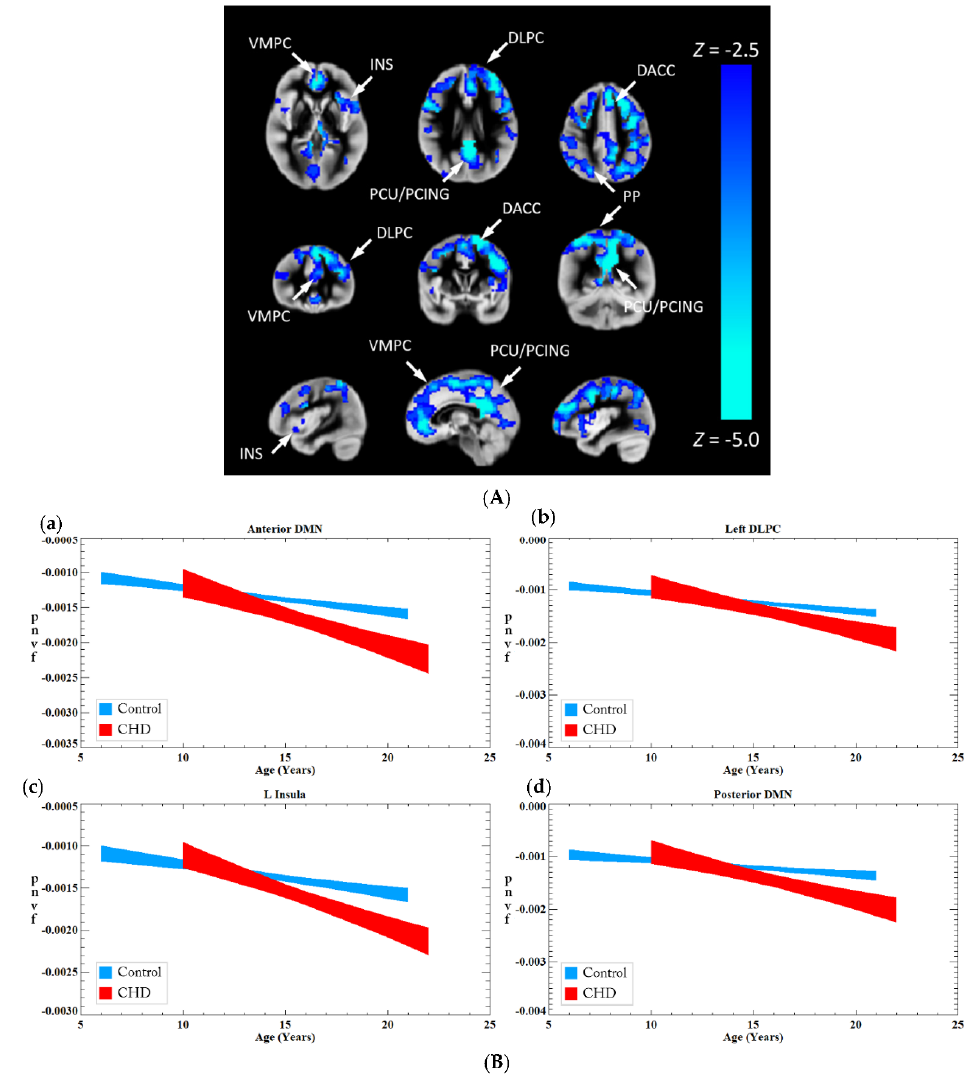
Figure 3. ( A ) A CHD-X-age interaction on Pnvf is present in children and younger adults. For illus- trative purposes, the trajectories of CHD patients and normal referents were computed separately for the ROIs shown to exhibit a significant interaction from the voxel-wise analysis depicted in ( B ). These plots show the fitted trajectories +/ − standard error of the fitted value (confidence interval = 67%). The plots show that, while at the earliest age (5 years) CHD patients have either the same or slightly higher Pnvf, the trajectory is such that they have substantially lower Pnvf by young adulthood. Regions with a negative CHD-X-age interaction on Pnvf (controlling for gender) are mainly concentrated in default mode network (DMN), central executive network (CEN), and salience network (SN) regions. The beta–age interaction values are as follows: Anterior DMN − 0.20 (0.09) L Insula − 0.19 (0.09), Left DLPC − 0.19 (0.09), Posterior DMN − 0.24 (0.09), R Insula − 0.20 (0.09) All regions significant at FDR-corrected q < 0.05 as see as blue voxel in ( B ). ( B ) Comparison of Pnvf as a function of age between CHD (red) and controls (blue) in specific regions shown in Figure 3: ( a ) dorsolateral prefrontal region; ( b ) insular cortex; ( c ) anterior cingulate; and ( d ) posterior cingu- late/precuneus; indicating that the Pnvf differences are more prevalent at older ages. (See Figure Legend for ( A ) for more detail). Abbreviations: default mode network (DMN), Ventrolateral medial prefrontal cortex (VMPC), Insula (INS), Dorsolateral prefrontal cortex (DLPC), Posterior Cingulate (PCING), Precuneus (PCU), Dorsal Anterior Cingulate Cortex (DACC), Posterior Parietal